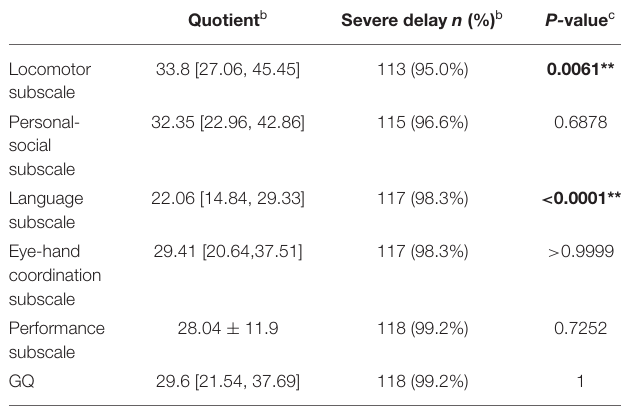
TABLE 1 | Results of GMDS-C assessment a